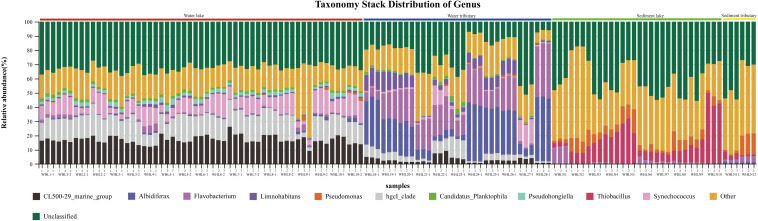
Taxonomy stack distribution at the genus level (top 10). There were three replicates per sample. The colored bars above the graph indicate different sample types.